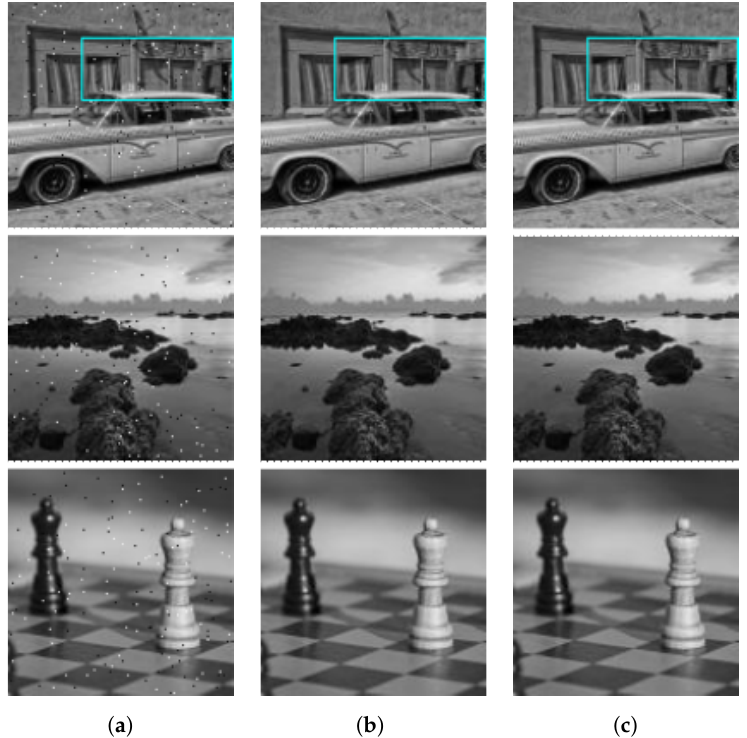
Figure 13. Original images taken from the Linnaeus 5 dataset [32] with 1.0% defective pixels added randomly along with example images showing the results of the defective pixel detection and correction process: ( a ) Original images with defective pixels. ( b ) Results of the proposed algorithm. ( c ) Results of the readout circuit.